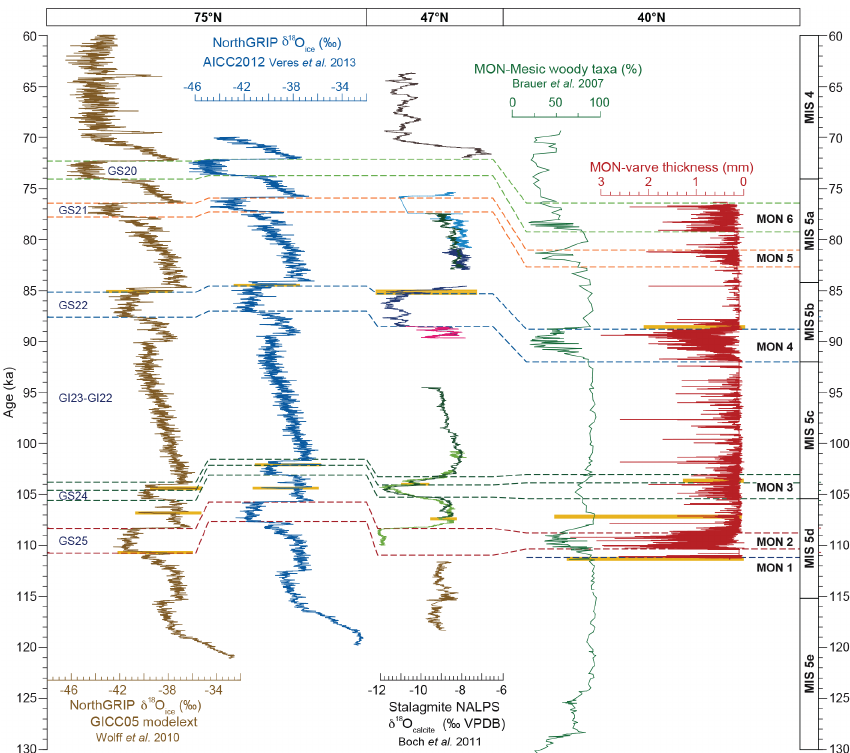
Figure 7. MON varve thickness and pollen record compared to the δ 18 O ice NorthGRIP record in both GICC05 modelext and AICC2012 timescales, NALPS record, covering a NW–SE transect from 75 to 40 ◦ N in western Europe. Marine isotope-5 sub-stages (MIS) start dates according to Wright (2000) and Greenland stadials (GS) identified in the δ 18 O ice NorthGRIP and δ 18 O calcite NALPS records are shown for comparison. Dashed lines indicate the boundaries of the MON oscillations and their correlatives GS. Duration of the GS is derived from Veres et al. (2013). The short-lived events within GS-24 and GS-22 are not included in the GI and GS duration estimates. Climate changes superimposed to millennial-scale variability are highlighted by the yellow